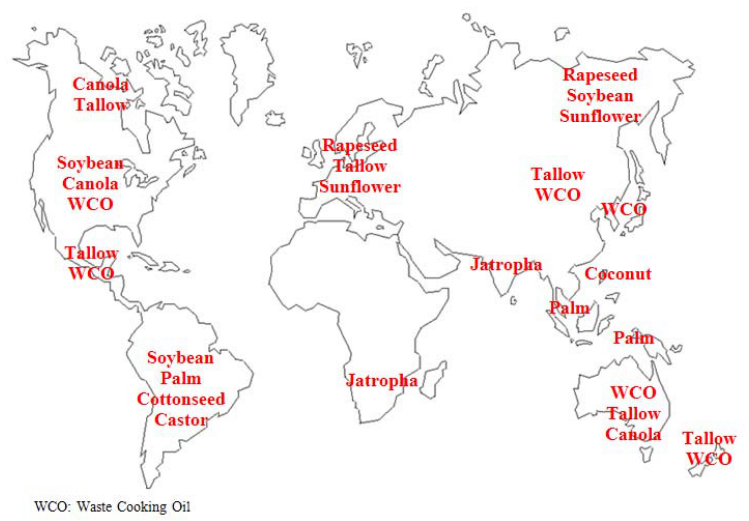
Figure 1. Biodiesel feedstocks around the